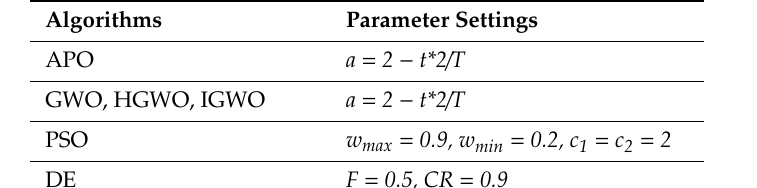
Table 17. The parameter settings for the other compared algorithms.